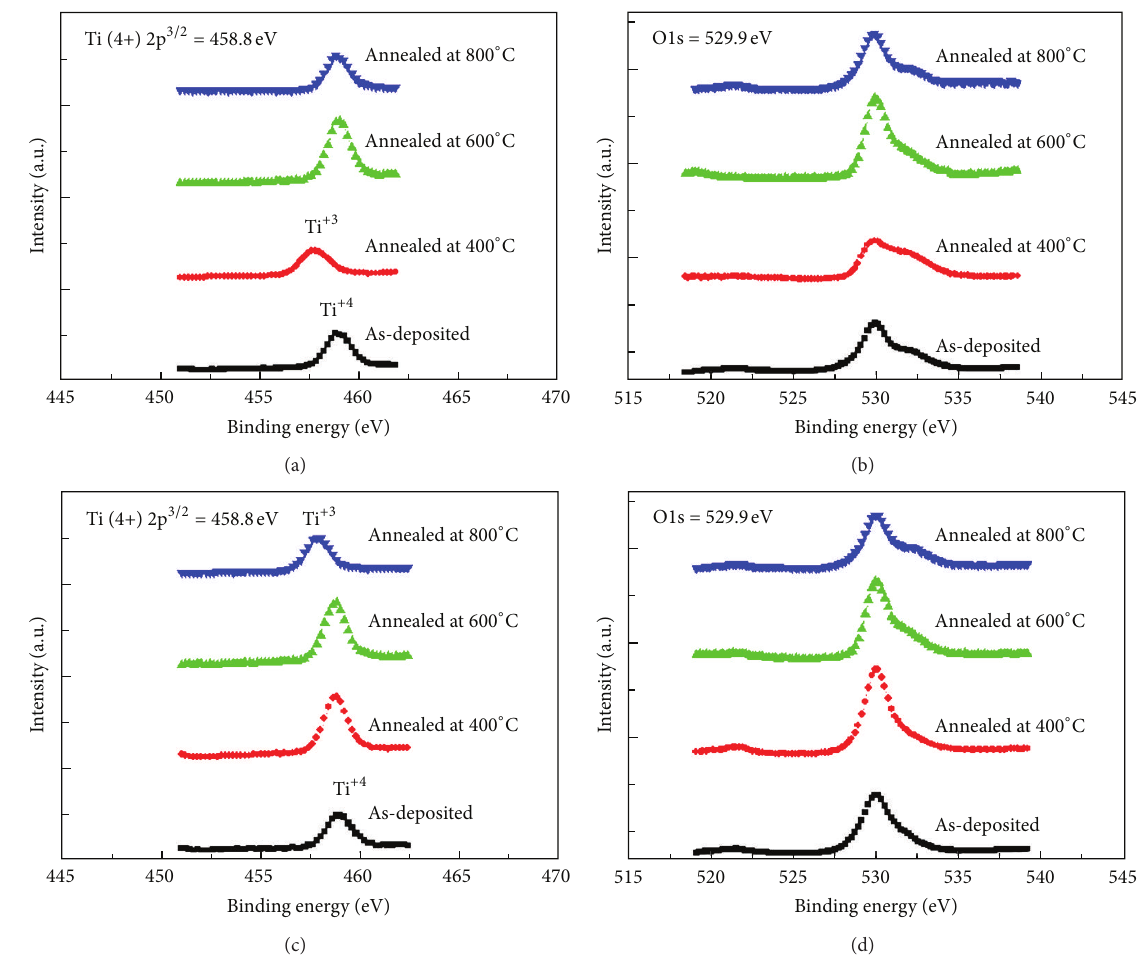
Figure 4: XPS spectra of TiO 2 films annealed at various temperatures: (a) Ti 2p 3/2 and (b) O1s from Ti 3 O 5 starting material and (c) Ti 2p 3/2